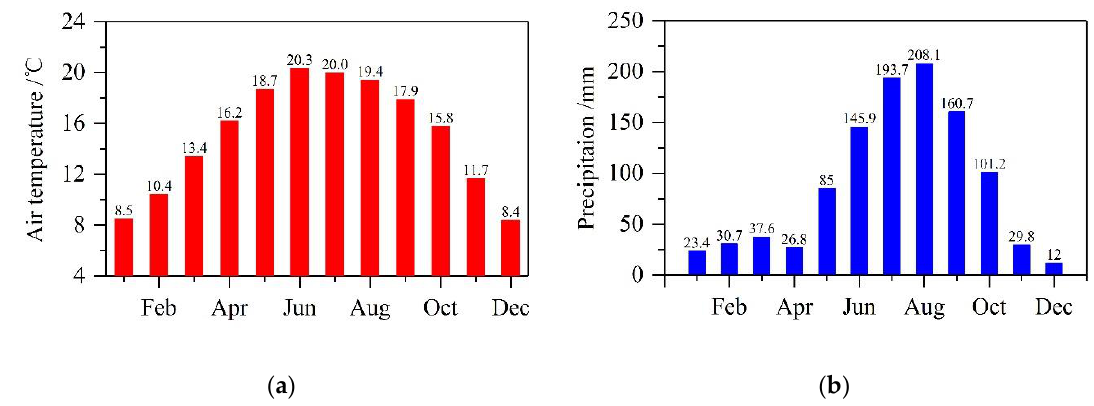
Figure 2. Monthly average air temperature ( a ) and precipitation ( b ) at the